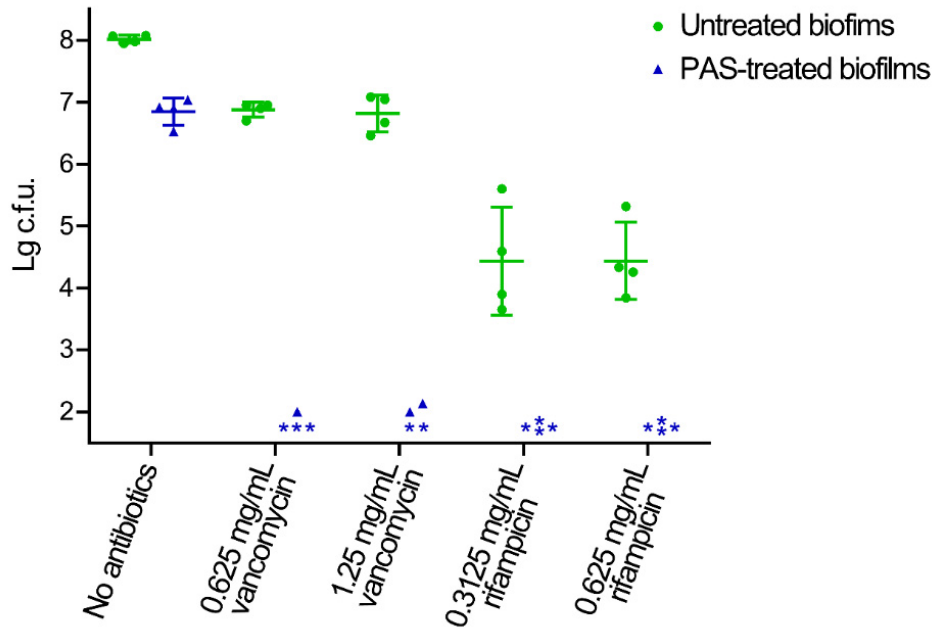
Figure 2. Inactivation of MRSA biofilms by the combination of PAS and antibiotics in vitro. The PAS-treated and untreated biofilms were incubated with TSB broth containing vancomycin or rifampicin. The treated and untreated biofilms were solubilized in 1 mL PBS by sonication and vortexing. Serial dilutions of each biofilm were performed and 10 µ L of each dilution was spotted onto TSB plates and incubated overnight at 37 ◦ C. The resulting colonies were counted and analyzed. The asterisks represent when the numbers of the colonies were less than the detection limit. Error bars represent the standard deviation (SD).